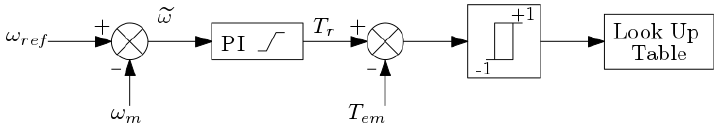
Figure 3. Block diagram of a cascaded PI